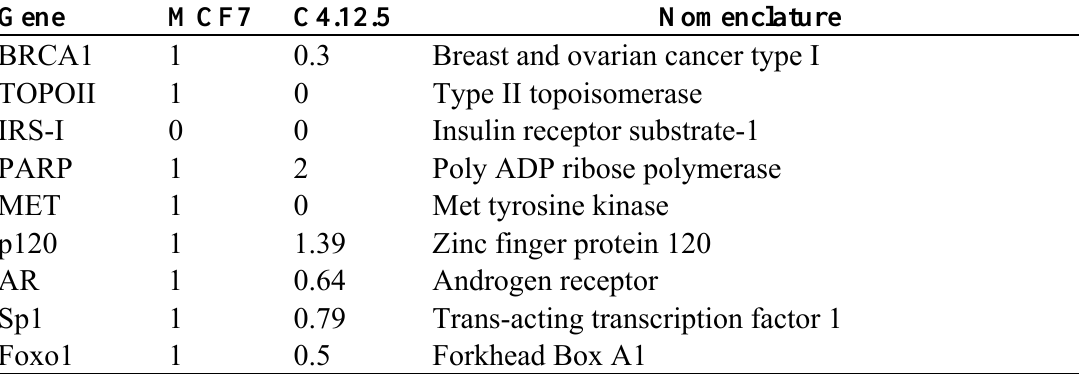
Table 3. Differentially expressed nuclear proteins identified by Westen blots in MCF7 and C4.12.5